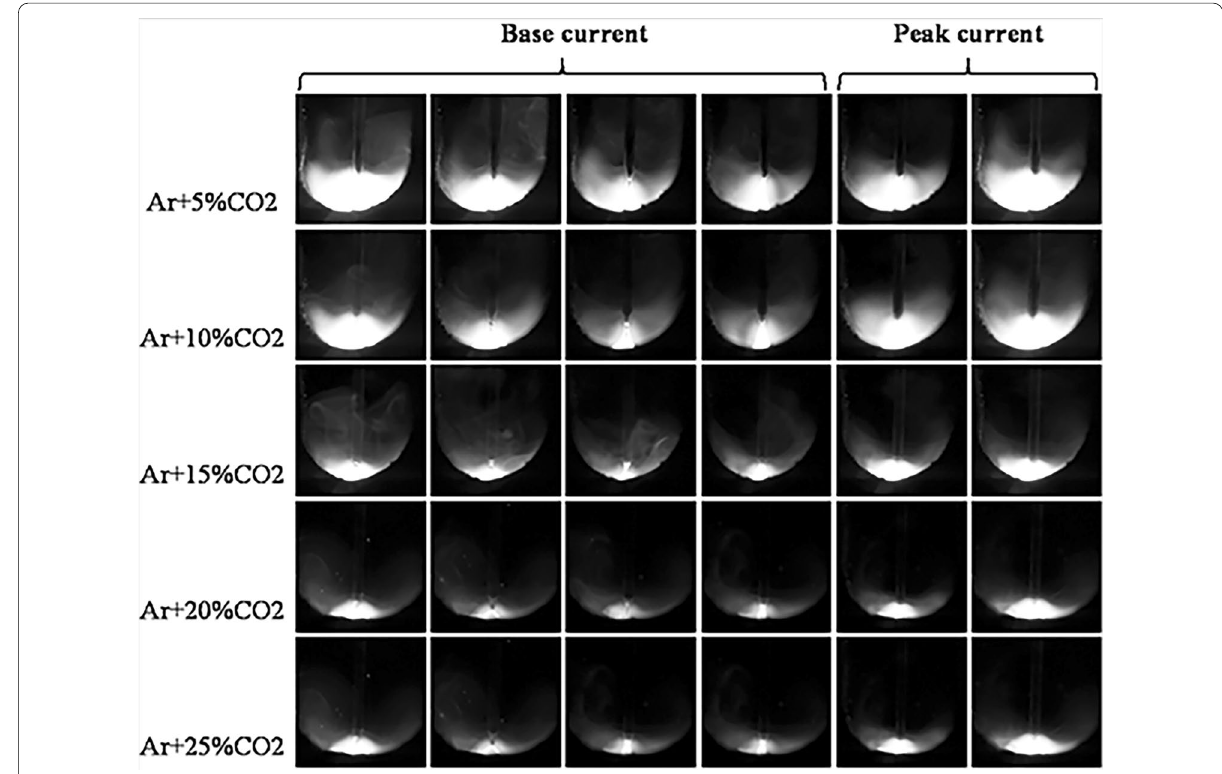
Figure 2 Variations of arc profile under shielding of gas mixtures with varied CO 2 contents